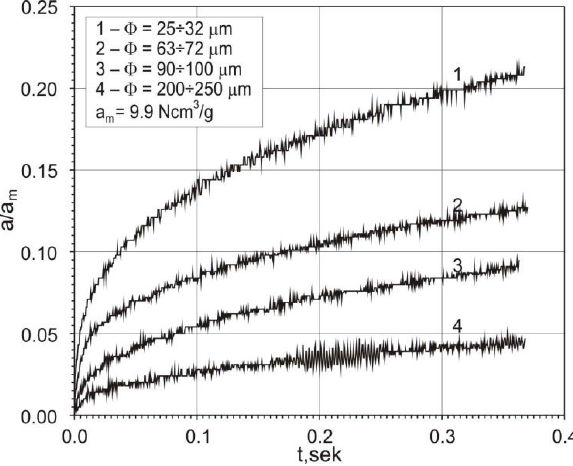
in the initial desorption period, 2